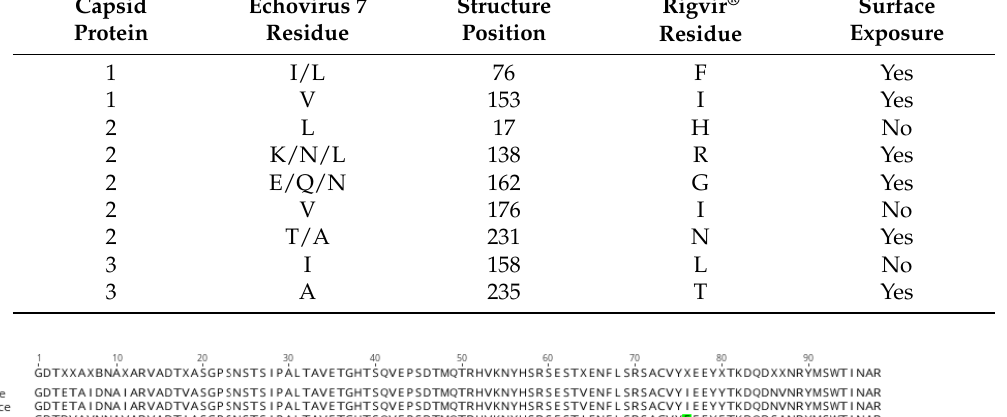
Table 1. Unique amino acid mutations present in Rigvir ® capsid proteins. Sequence positions indicated as in echovirus 7 crystal structure PDB ID 2X5I.